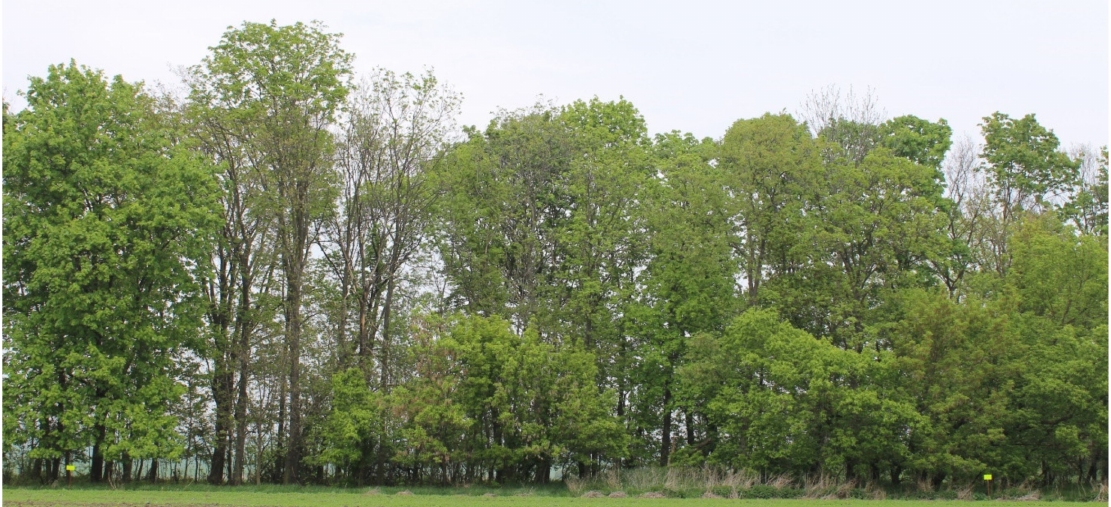
Figure 6. Study locality Micmanice: windbreak 2.